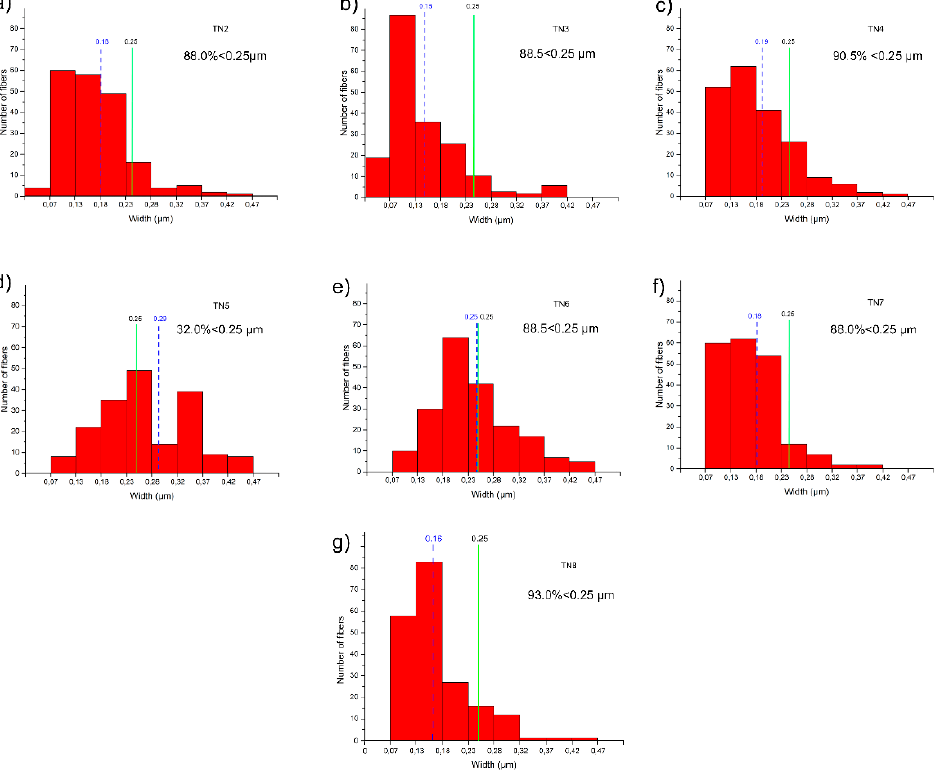
Figure 9. Width distribution of Ni-doped tremolite fibers; ( a ) run TN2 (88.0% < 0.25 µ m); ( b ) run TN3 (88.5 < 0.25 µ m); ( c ) run TN4 (90.5% < 0.25 µ m); ( d ) run TN5 (32.0% < 0.25 µ m); ( e ) run TN6 (88.5 < 0.25 µ m); ( f ) run TN7 (88.0% < 0.25 µ m) and ( g ) run TN8 (93.0% < 0.25 µ m), as calculated by measuring 200 single fibers for each run. The blue line shows average value. The green line at 0.25 µ m can be considered as a thickness threshold; hence, based on Stanton’s hypothesis these fibers may be considered potentially carcinogenic.